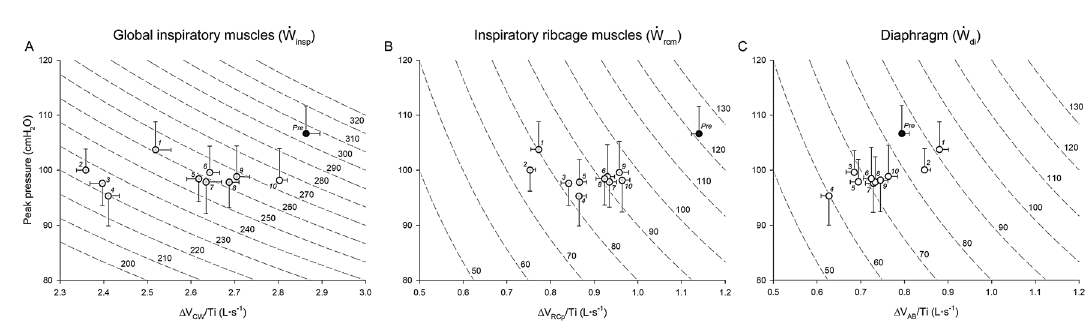
Figure 5. Relationships between mean values of peak pressure ( y -axis) and shortening velocity index ( x -axis) of global inspiratory (ΔV CW /Ti – panel A ), ribcage (ΔV RCp /Ti –panel B ), and diaphragm (ΔV AB / Ti – panel C ) muscles. Dotted lines represent isopleths of different levels of mechanical power ( Ẇ ) from 200 to 320 cmH 2 O·L·s -1 (left panel), and from 50 to 130 cmH 2 O·L·s -1 (middle and right panels), according to the relationship Ẇ = pressure × shortening velocity. Black dots represent mean pre-fatigue values of all 26 subjects included. The remaining dots represent mean peak pressure values obtained from SNIPs performed during recovery (significant values [grey] and non-significant values [white]). Vertical and horizontal bars represent ± SE values of peak pressure and shortening velocity indexes, respectively. Numbers near dots represent the order of SNIP maneuvers during